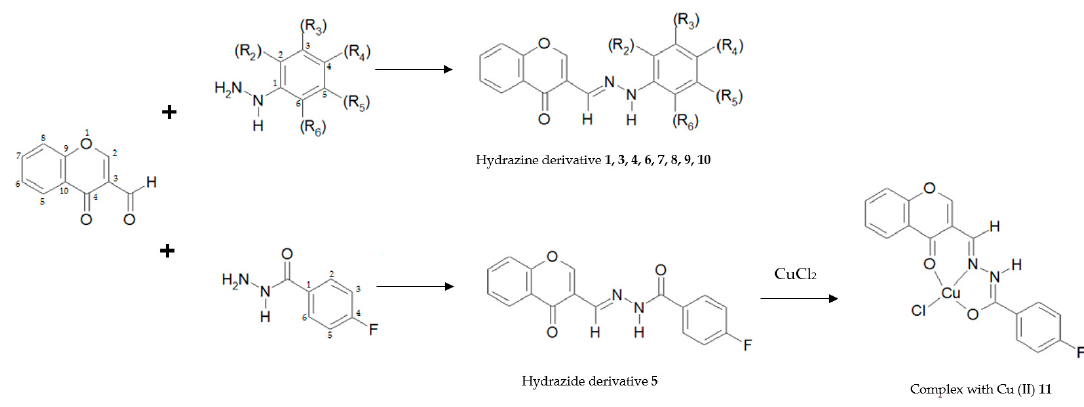
Scheme 1. Synthesis of hydrazine and hydrazide derivatives of 3-formylchromone. Reaction